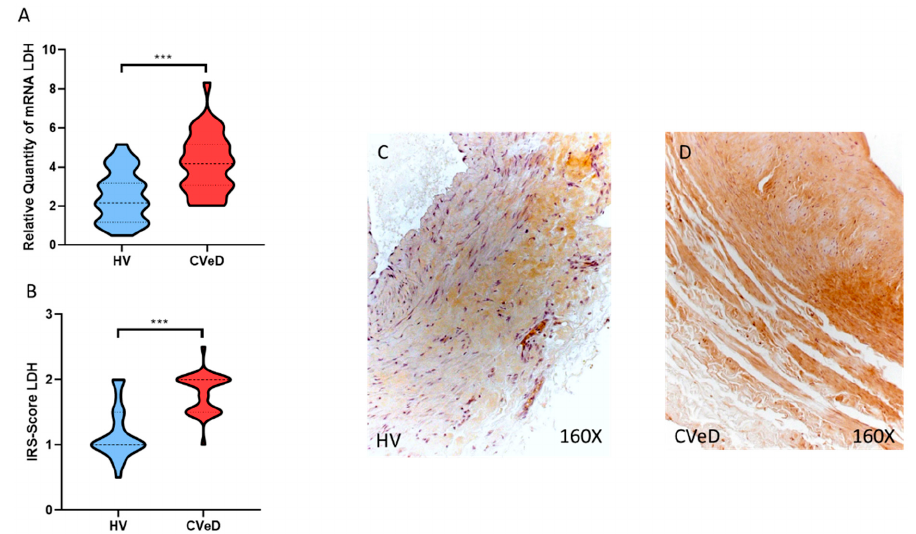
Figure 5. ( A ). LDH mRNA expression in the HV group (healthy controls) and CVeD patients (chronic venous disorder). ( B ). IRS-Scores for LDH in the venous wall of the HV group and the CVeD group. ( C – D ). Images showing the immunostaining for LDH in the C group in the three tunicae of the venous wall. p < 0.001 (***).